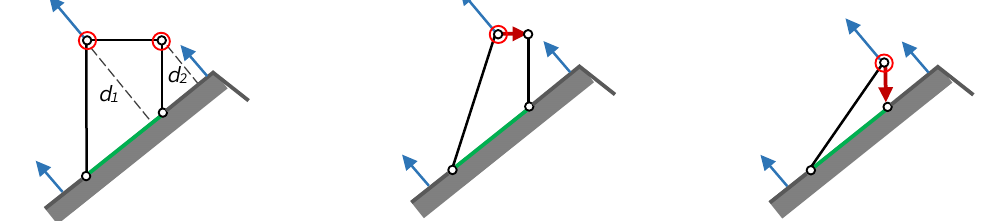
Figure 9. Sweep Plane transformation of an element with an inclined joint